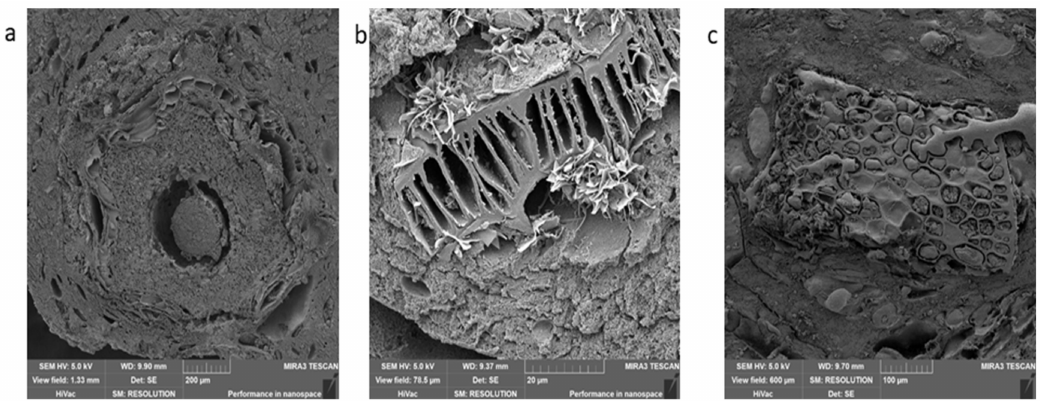
Figure 9. Spices found in samples: ( a )—caraway, ( b )—mustard, ( c